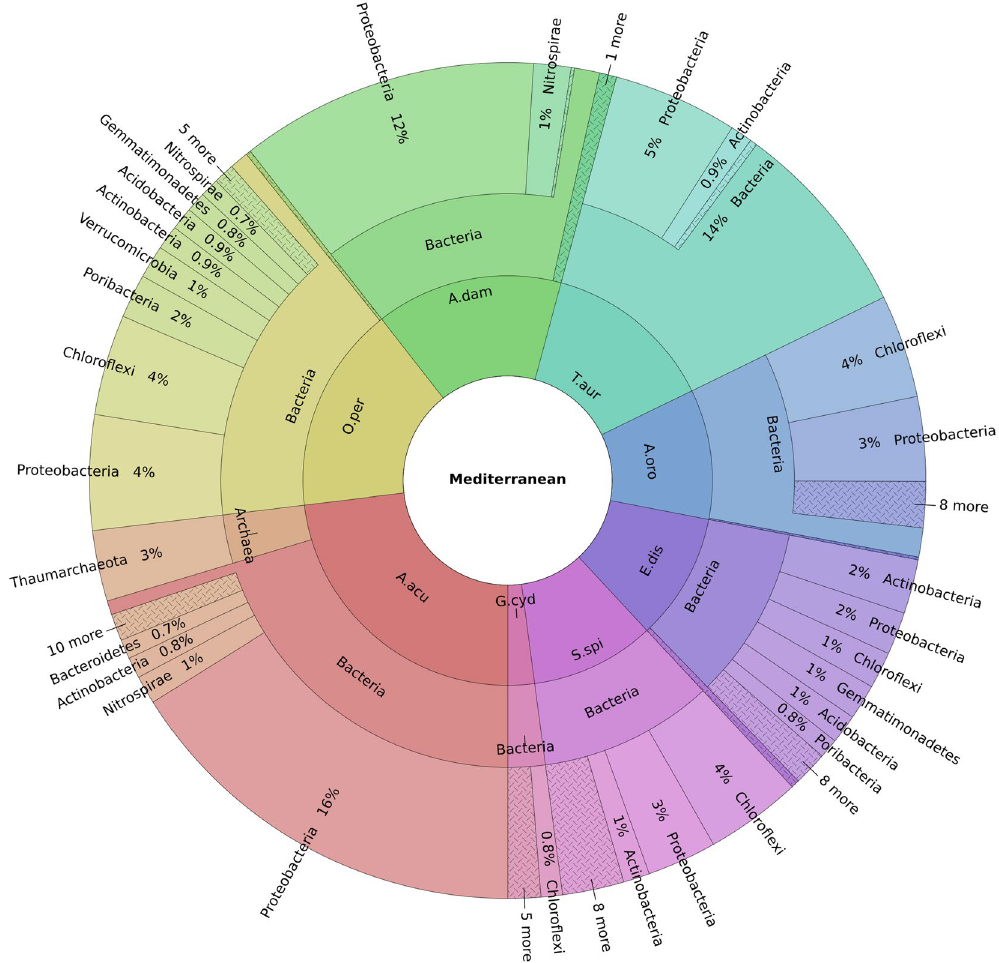
Figure 4. Krona Plot representing the most abundant phyla for each sponge under analysis. Sample code: T.aur = T. aurantium ; A.dam = A. damicornis , A.acu = A. acuta , O.per = O. cf. perforata , S.spi = S. spinosulus , E.dis = E. discophorus , A.oro = A. oroides and G.cyd = G. cydonium